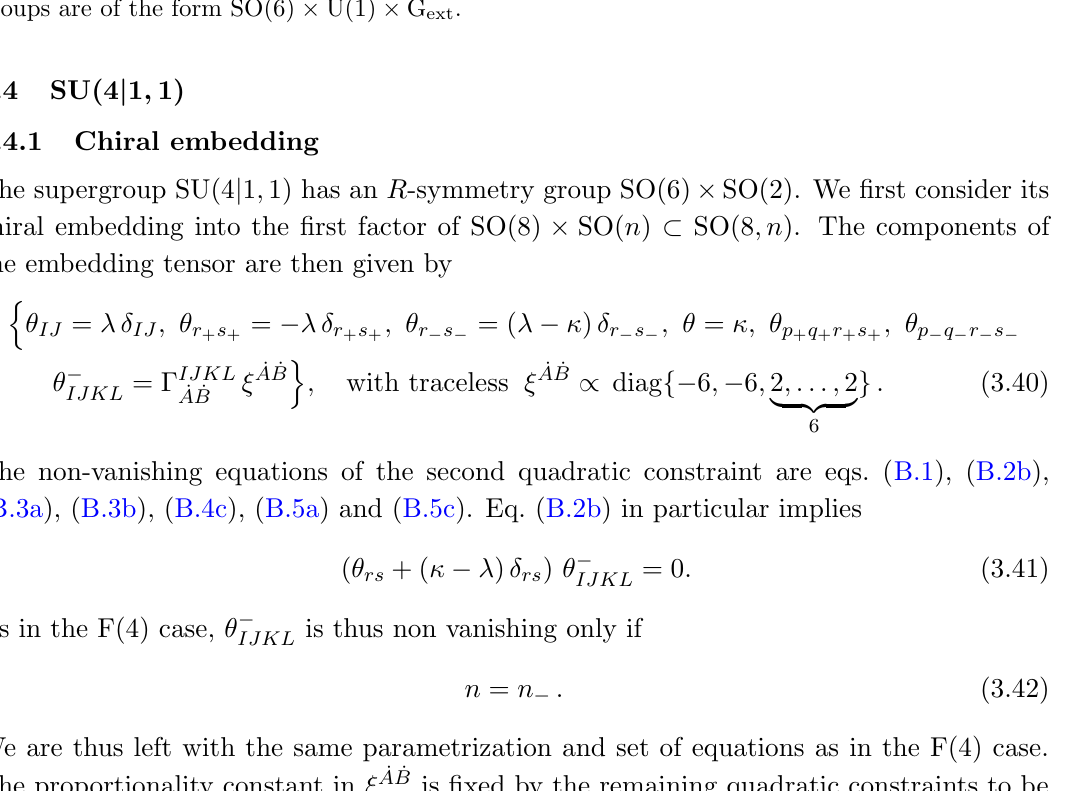
Table 6. Mass spectrum for the SU(4 groups are of the form SO(6)